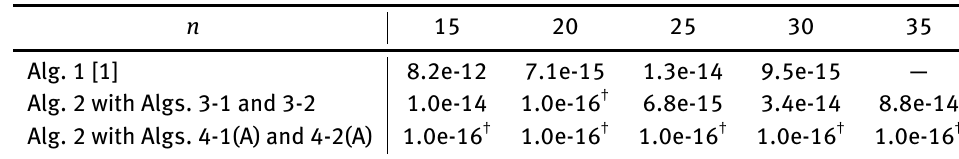
Table 3: Relative errors between the approximate minimum singular value of T in Table 1 and the minimum singular value of T computed by svd . The superscript † indicates that the relative error in (20) equals 0. The symbol “—” means that the algorithm did not converge to the minimum singular values of T